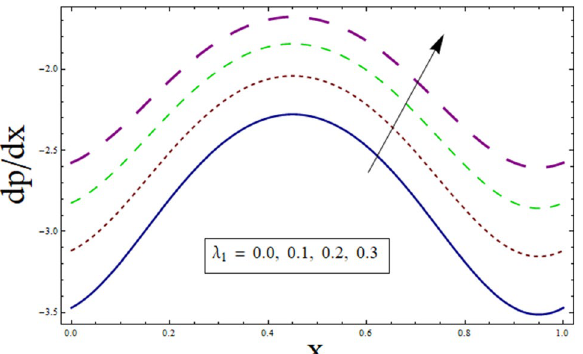
Figure 18. dp/dx for (cid:31) 1 .